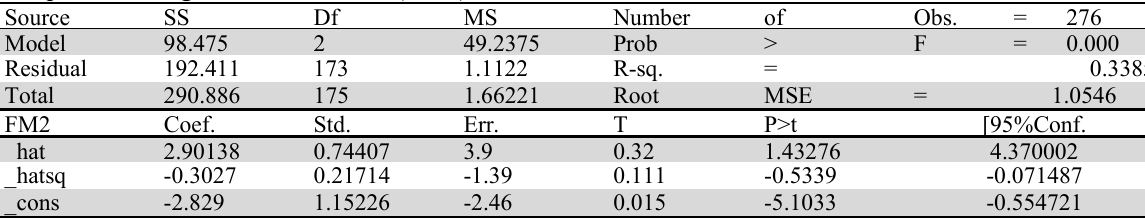
Adequate staffing of financial staff (FM2)